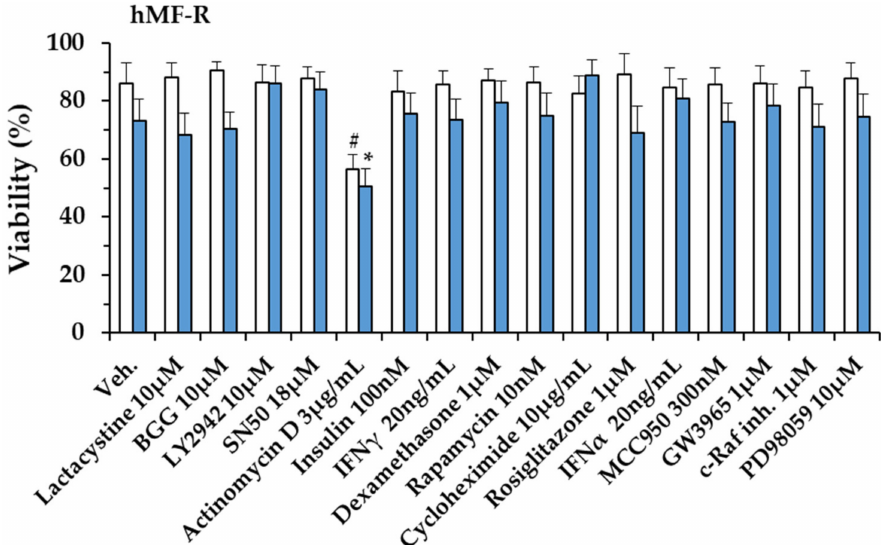
Figure 6. Analysis of di ff erent pathway targeting on the viability of hMFs treated with TRB for 24 h. hMFs from either sensitive (hMF-S; n = 5) or resistant (hMF-R; n = 12) donors were treated with the indicated compounds, and cell viability was determined by flow cytometry. Results show the means + S.E.M. from the indicated number ( n ) of healthy donors for each group of hMFs. * p < 0.05; ** p < 0.01; *** p < 0.001 vs. the corresponding to the vehicle condition; # p < 0.05 vs. the Veh. condition (drug-untreated condition).